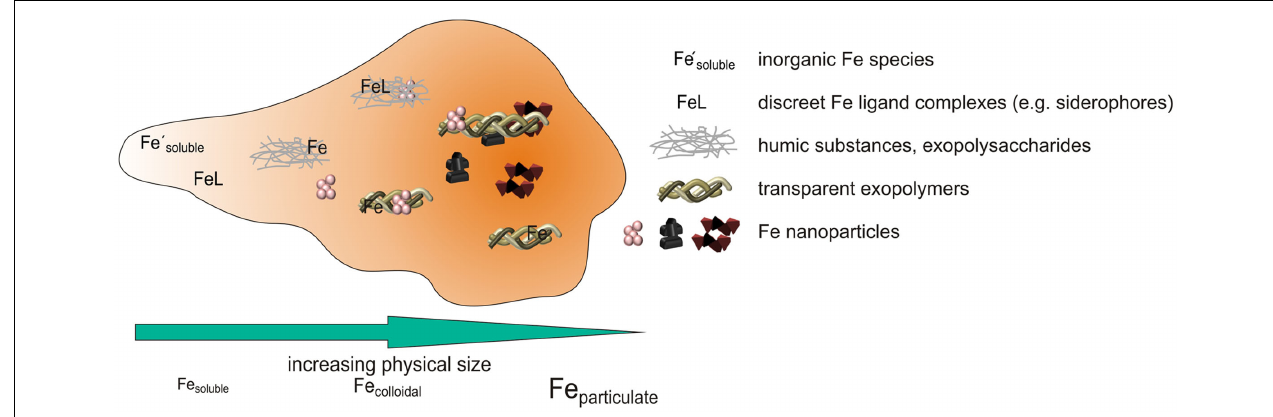
FIGURE 4 | Schematic figure illustrating potential components of the dFe pool so far identified in seawater. Decreasing kinetic lability of Fe within the components is represented by deeper orange background shading.